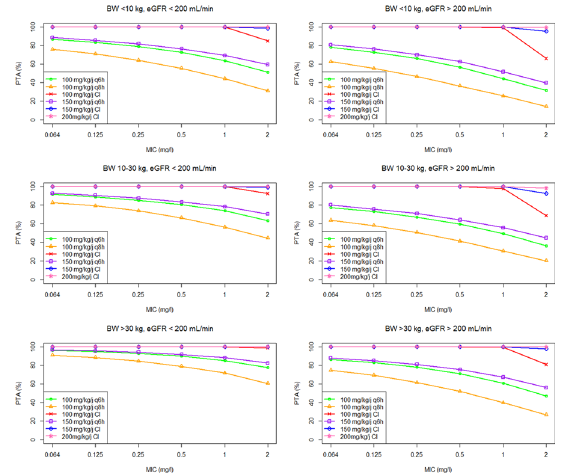
Fig. 1 Probability of target attainment obtained on 39,000 simula‑ tions from study population for a target defined as 100% 〖 fT 〗 _ (4